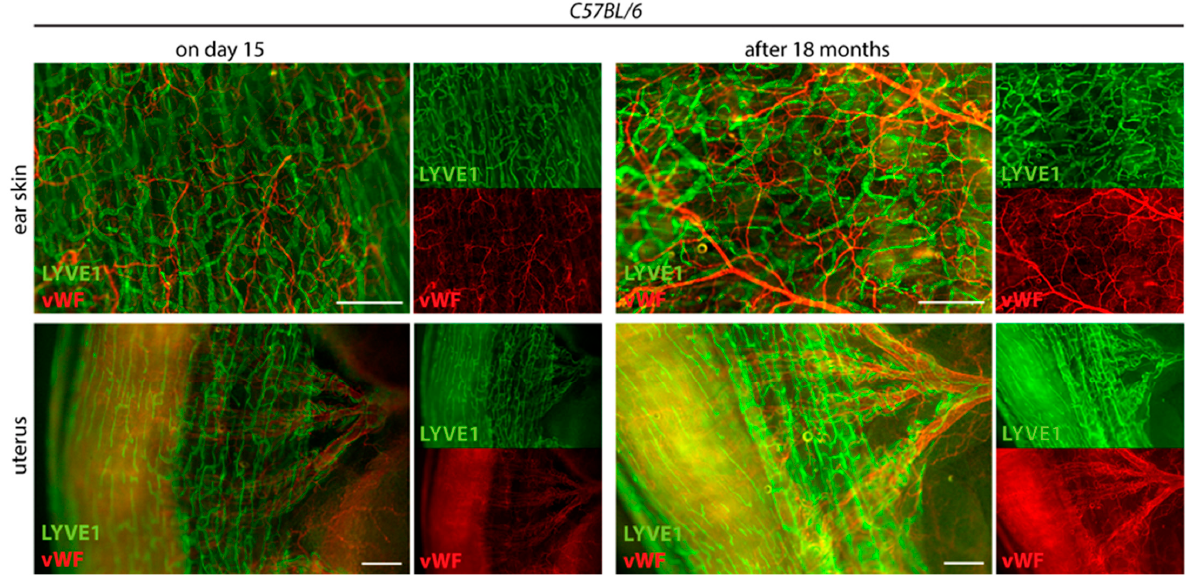
Figure 5. Long-term stability of the fluorescence signal. The tissue-cleared and stained ear skins and uteri of C57BL/6 mice are shown on day 15 at the end of the tissue-clearing protocol and 18 months later. Samples were stained with the lymphatic marker anti-LYVE1 and anti-von Willebrand Factor (vWF). Samples were stored at 4 °C in Reagent 2. Images were acquired by stereo microscopy, scale bar 500 μ m (n = 3 organs of 3 mice). Representative images of the experiments are shown.